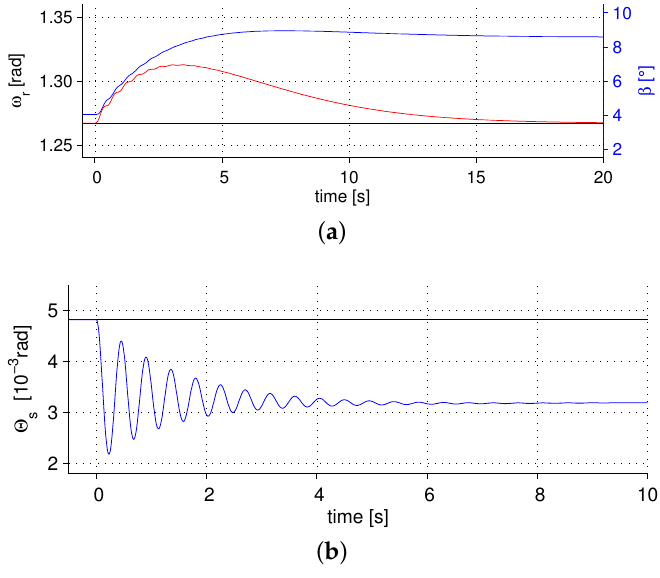
Figure 10. Generator failure in the full load region at constant wind speed 12 m/s. ( a ) Total generator torque T g (red line), demanded torque T g , d (black line), pitch angle β (blue line); ( b ) shaft torsion angle Θ Θ s (bue), demanded angle s